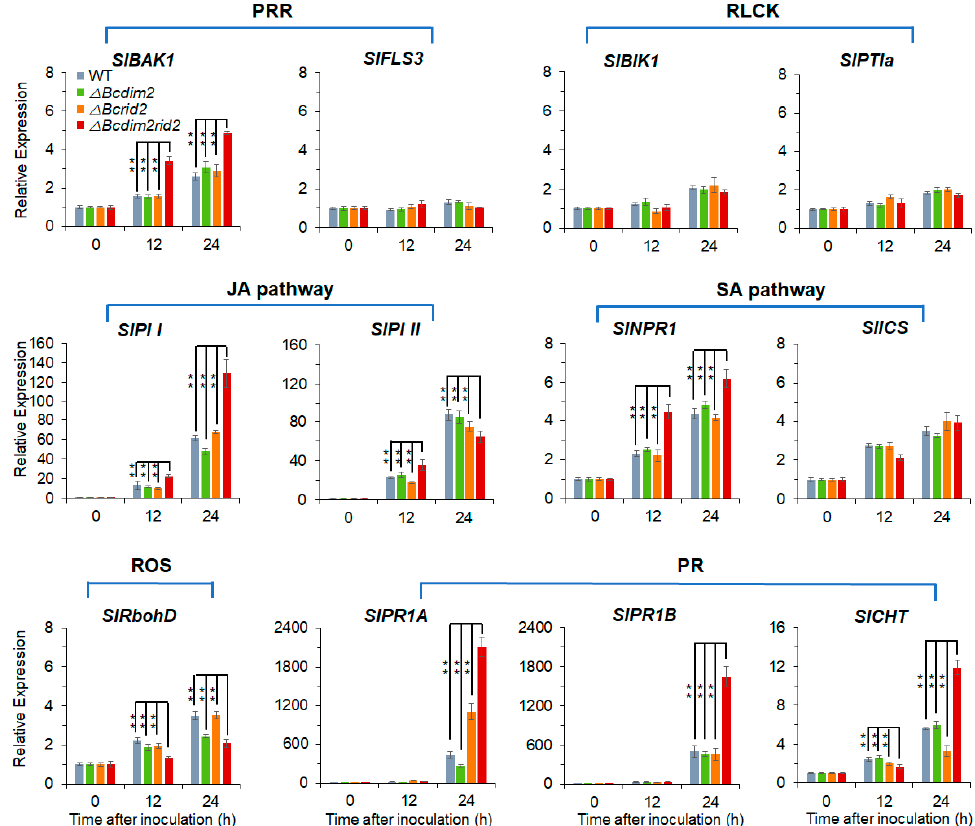
Figure 8. The expression of resistant genes in fruit is induced by ∆ Bcdim2rid2 . PRR: pattern recognition receptors (or coreceptor); RLCK: receptor-like cytoplasmic kinases; JA pathway: jasmonic acid pathway components; SA pathway: salicylic acid pathway components; ROS: NADPH oxidase; PR: pathogenesis-related genes. Asterisks indicate significant differences between △ Bcdim2rid2 and other strains (** p < 0.01).